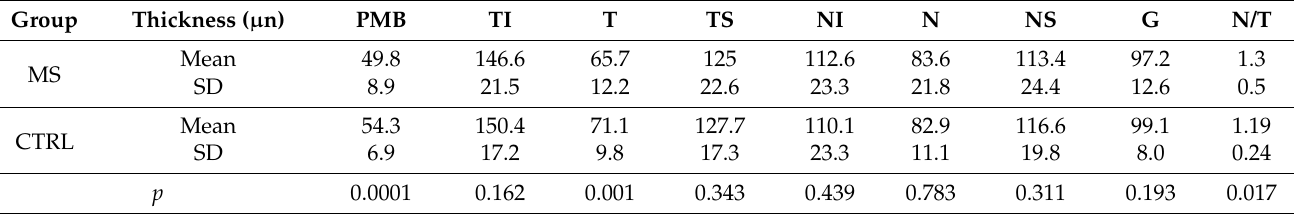
Table 3. Peripapillary RNFL thickness values provided by RNFL-N axonal analytics and statistical differences in autoso- mal dominant optic atrophy (ADOA) and control subjects.